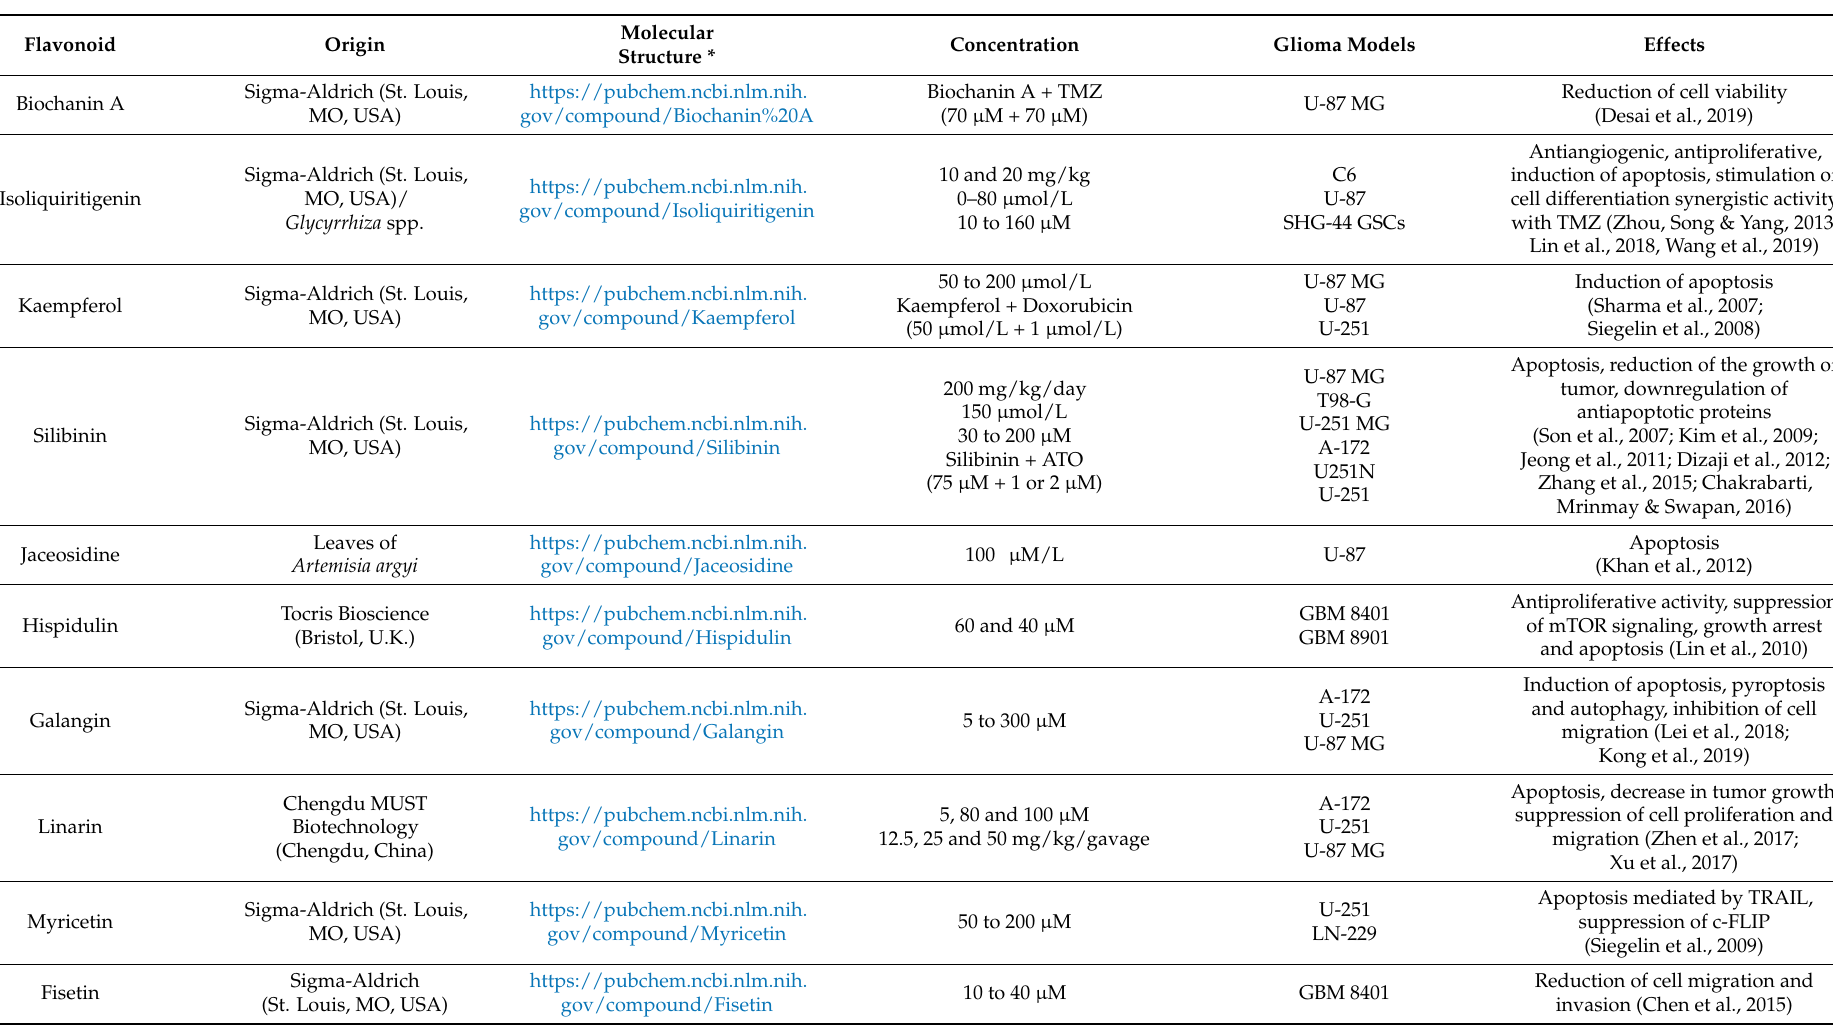
Table 1. A synthesis of studies that demonstrated effects of flavonoids in glioma